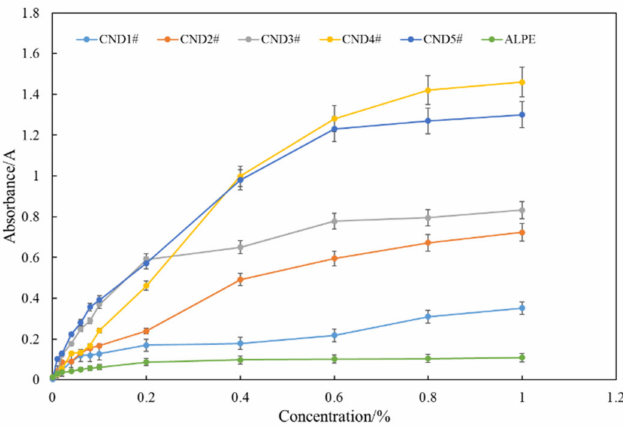
Figure 5. Standard curve of concentration versus absorbed light intensity.